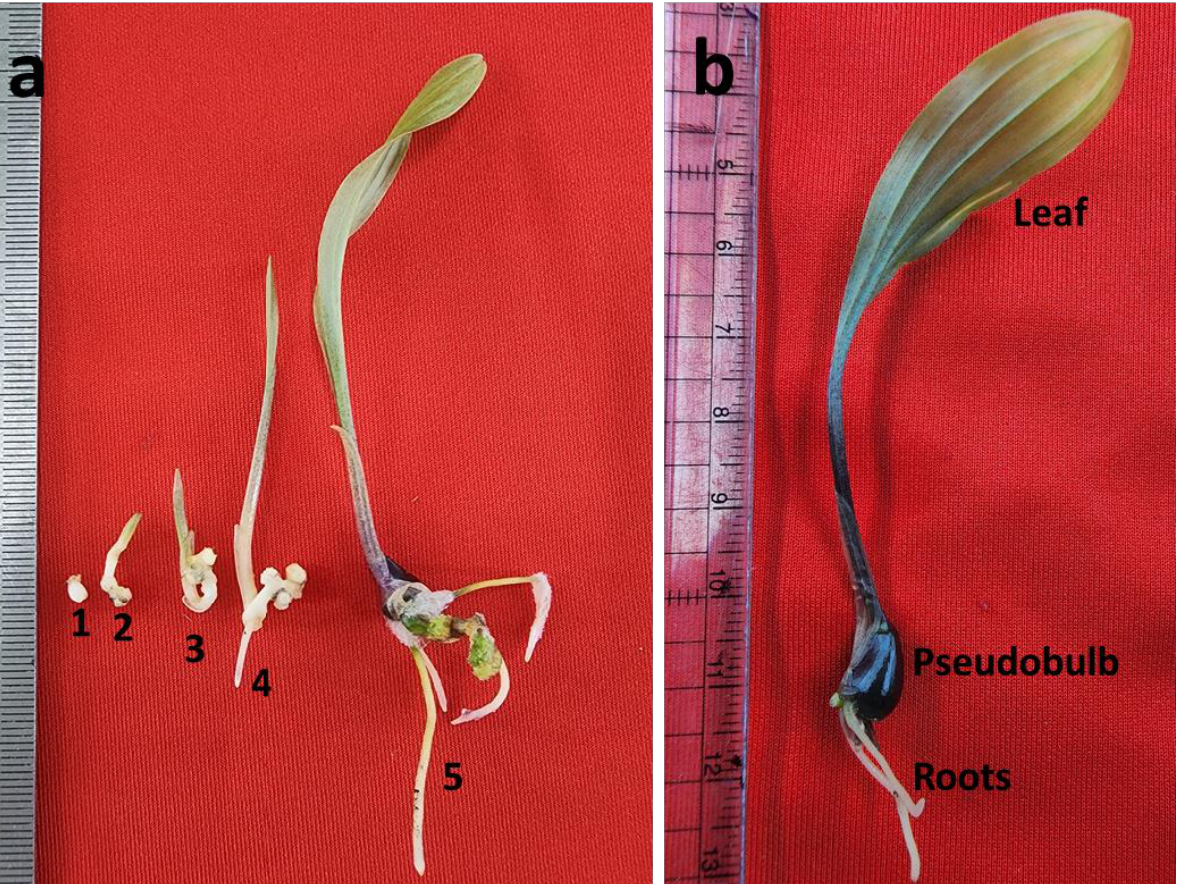
Figure 3. Protocorm conversion and SLC development: ( a ) different stages of protocorm conversion (1 – 4) and seedling development (5); ( b ) SLC seedlings with pseudobulb. 1 (0-day), 2 (18-day), 3